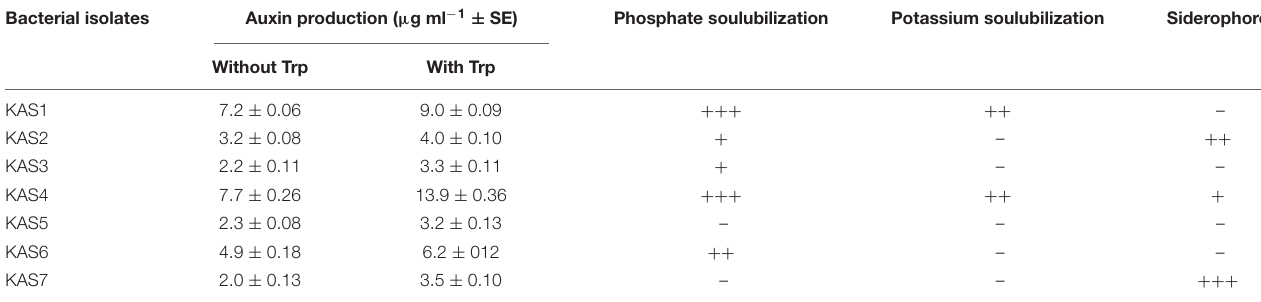
TABLE 2 | Auxin (IAA) production, phosphate solubilization, potassium solubilization, and siderophore production activities of seed endophytic bacteria. Bacterial